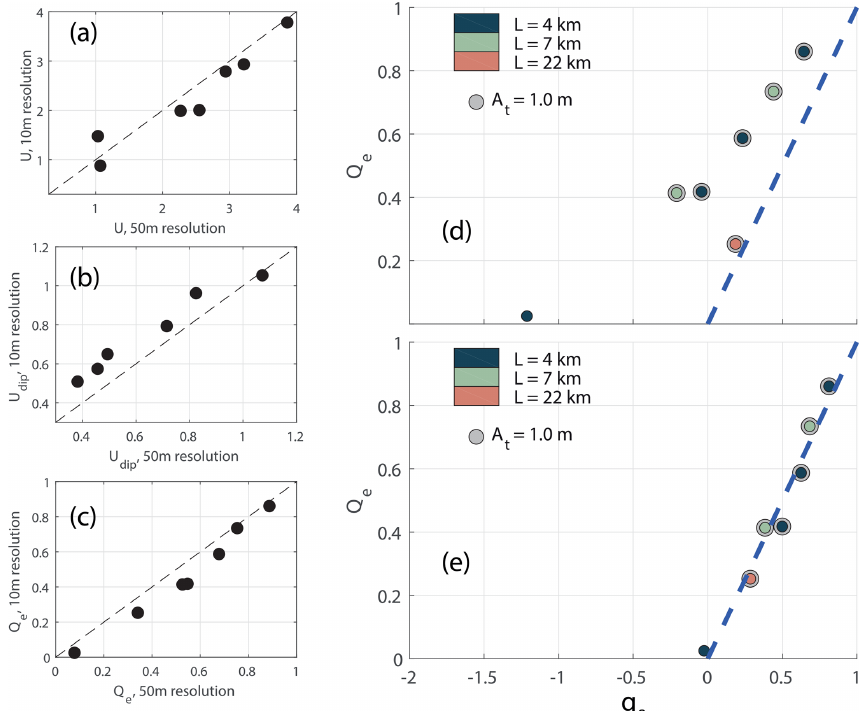
Figure 20. Comparison between 10 and 50m resolution simulations. Panels (a–c) show the comparison in velocity scale U , dipole propa- gation velocity U dip , and effective transport Q e . Panels (d, e) show the effective transport Q e (Eq. 19) from the finer-resolution simulations plotted against the effective transport resulting from the simple kinematic model (Eq. 30) for (d) X d = 1 and (e) X d = 1 . 67. The dashed line indicates Q e = q e . Dipoles, recognized from the criteria given in Sect. 5, are marked with a gray